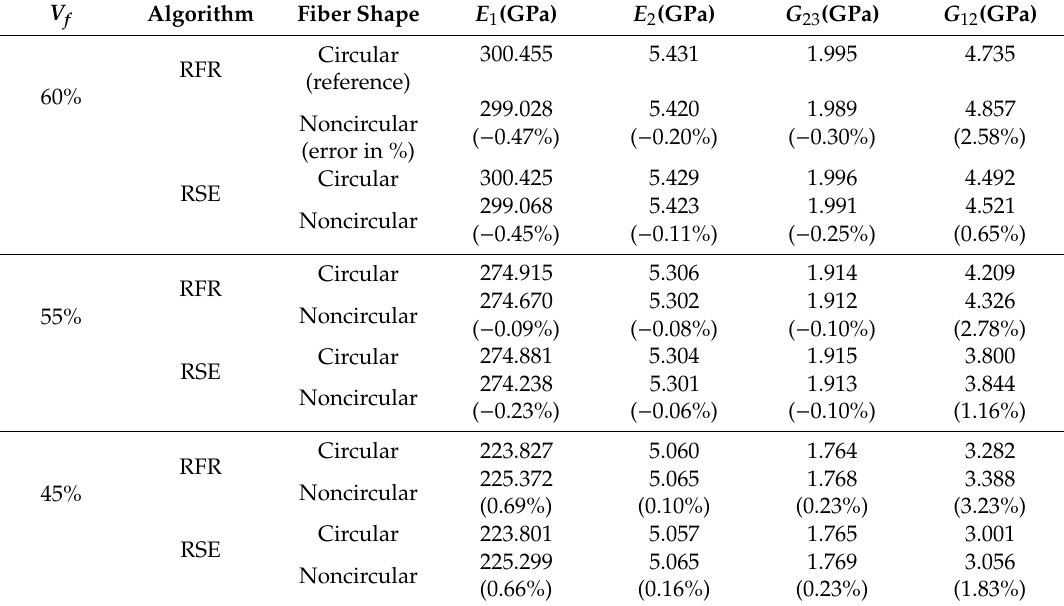
Table 4. Comparison of the e ff ective elastic properties of M55J / M18.